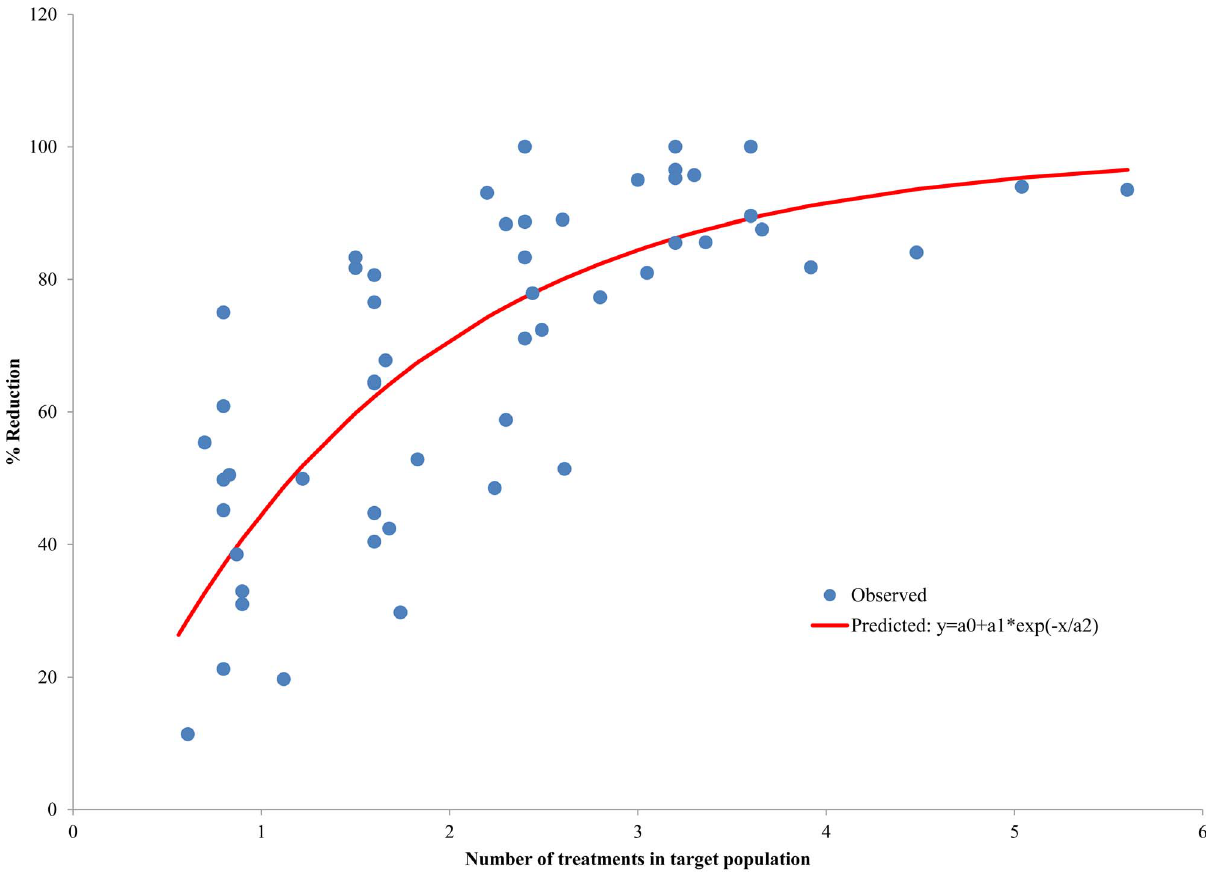
Figure 1. Empiric observations defining the relationship between number of treatments per person and % reduction in Mf prevalence 1 year later.